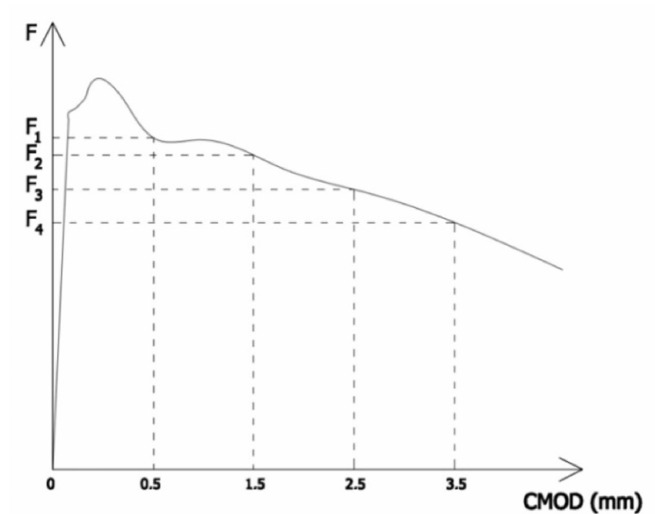
Figure 3. Graphic interpretation of determining the values F 1 to F 4 [31].